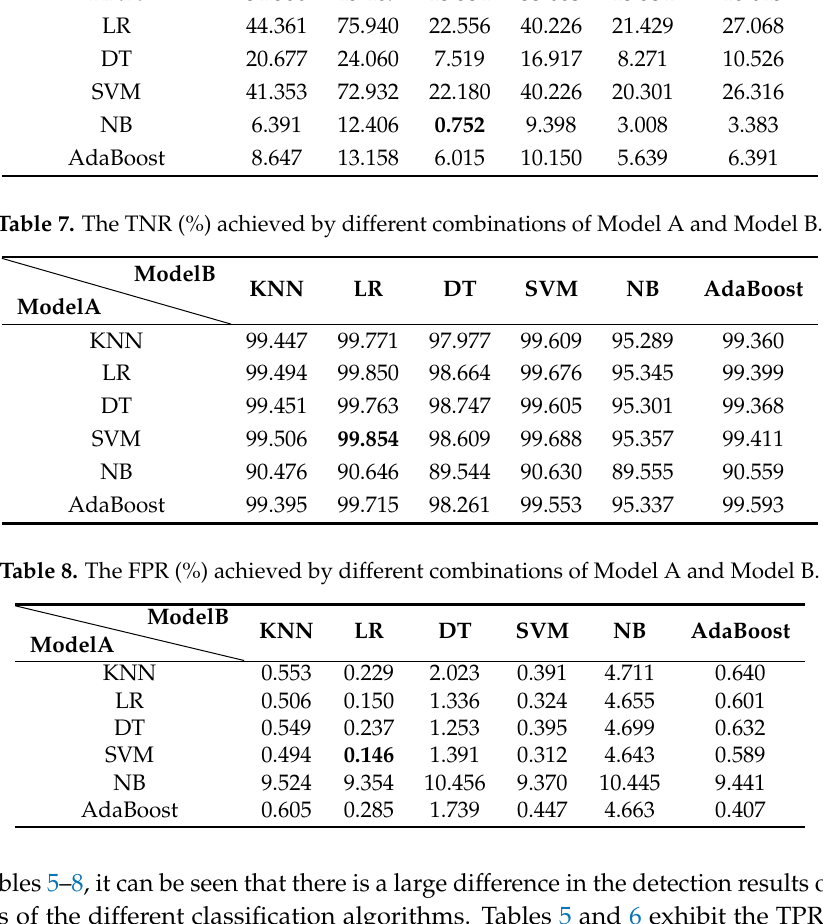
Table 6. The FNR (%) achieved by different combinations of Model A and Model B.